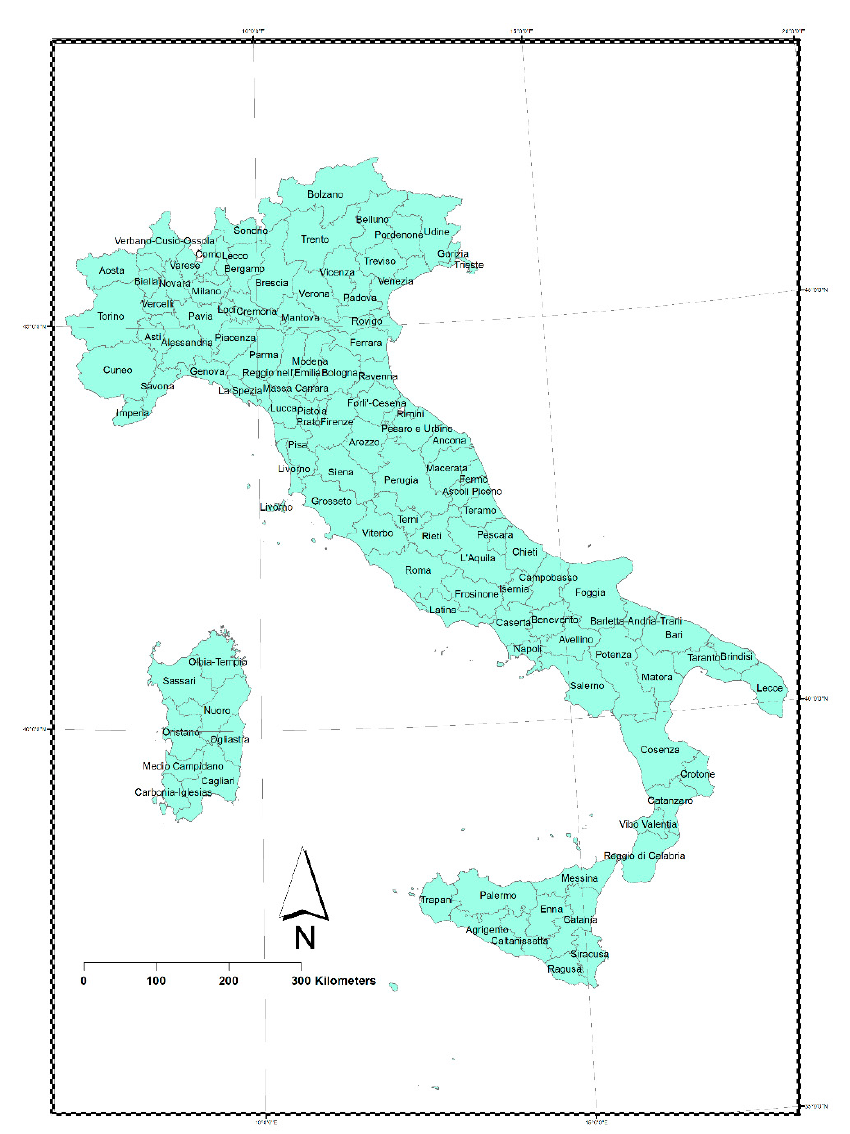
Figure 1. Study area and NUTS 3 (Province) subdivision.